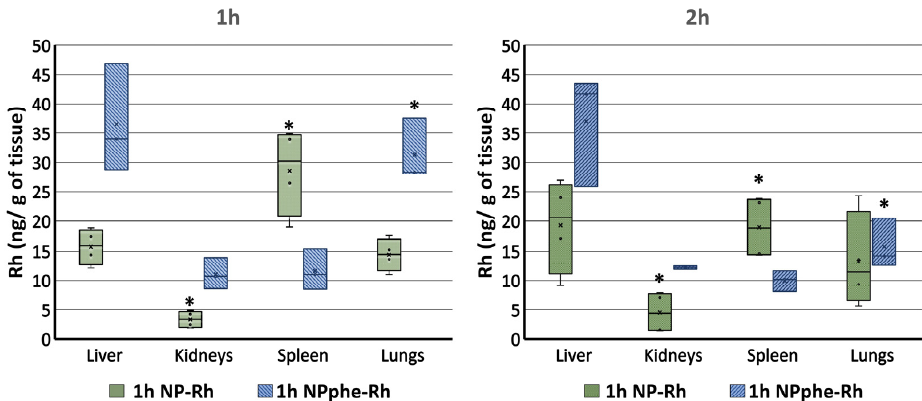
Figure 4. Mean amounts ( ± SD) of Rh-B in different organs at times 1 h and 2 h. * Statistically significant differences ( p -value < 0.05).